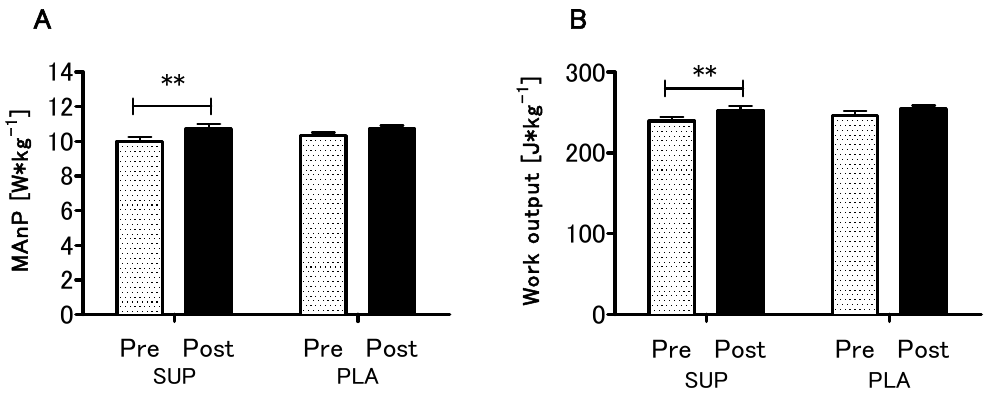
Figure 5. Effect of vitamin D supplementation on maximal anaerobic power MAnP ( A ) and work output ( B ). Values are means. Error bars indicate ± SEM (standard error of mean). ** = p < 0.01.